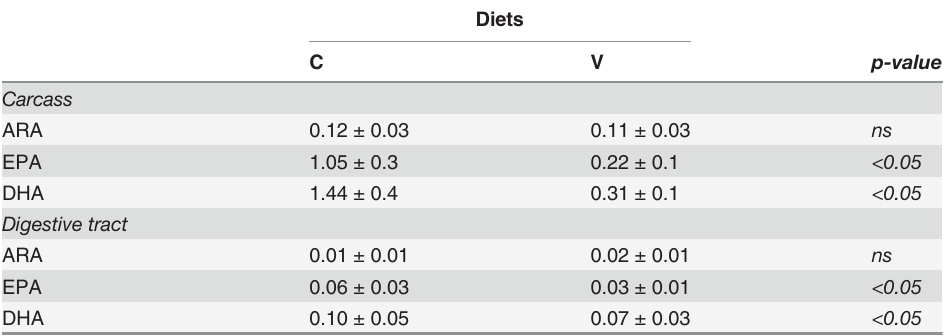
Table 6. ARA, EPA and DHA content (g/100g tissue) in carcasses and digestive tracts of C- and V- fed females.